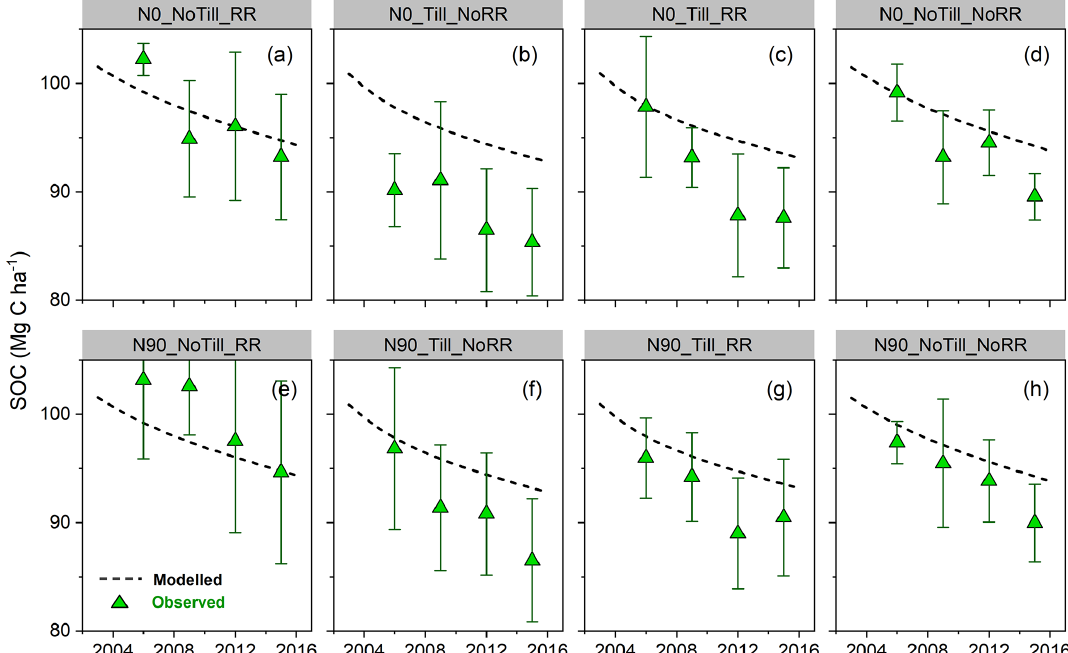
Figure 3. The same as Fig. 2, but at the CT1 site. See Table 2 for the treatment abbreviations and their explanations.